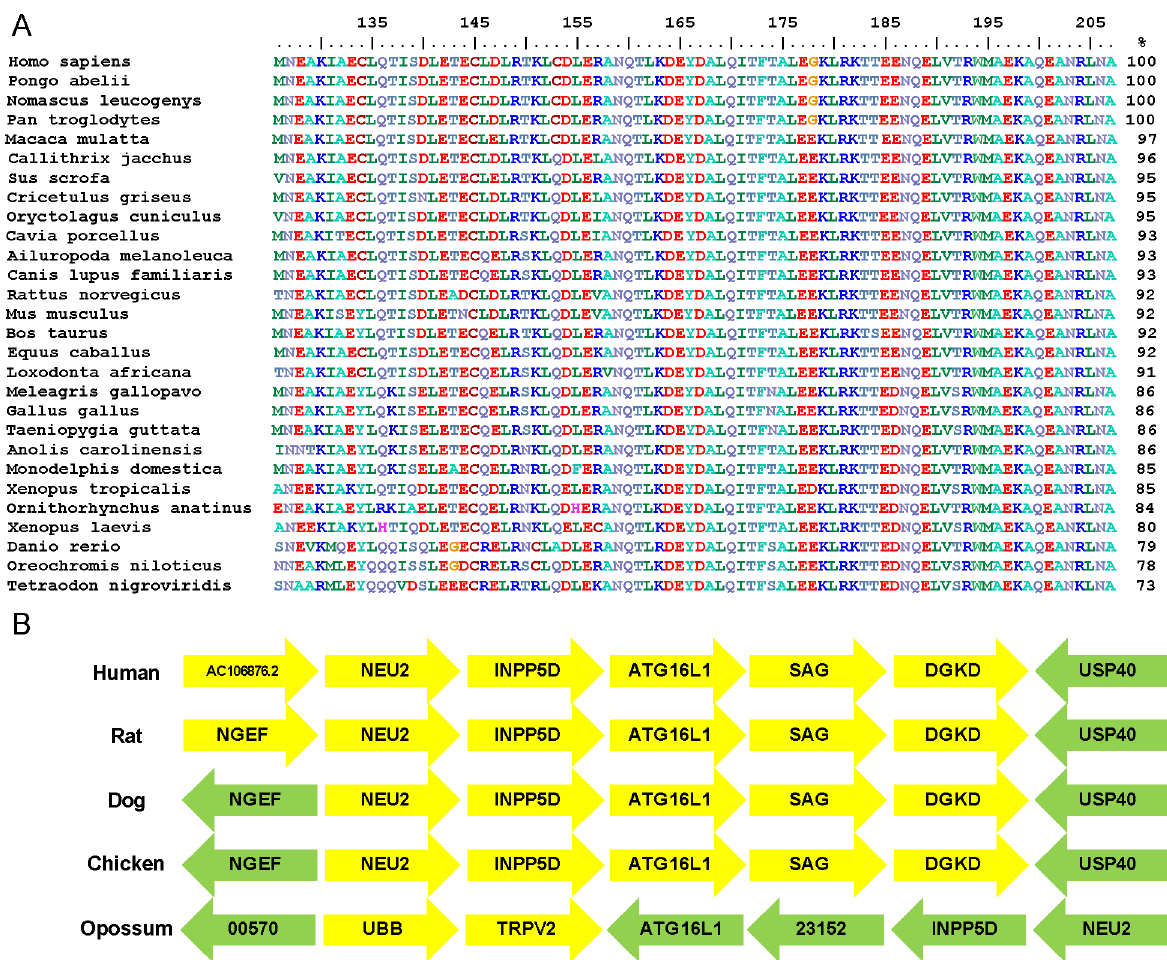
Figure 5. The coiled-coil of ATG16L1 is highly conserved across vertebrates. (A) Cross-species alignment of the coiled-coil (human residues M126 – A207) of ATG16L1 reveals levels of sequence identity with the human sequence of between 73% and 100%. The percentage identity listed is in comparison with the human sequence. The common names and database identifies for each sequence are listed in Materials and Methods. (B) The syntenic position of Atg16L1 is well conserved across species. The three adjacent upstream and downstream genese to Atg16L1 are displayed. Genes are denoted by individual blocks; yellow indicates a position on the forward strand and green a position on the reverse strand. Gene identities are as follows: ATG16L1 – autophagy related protein 16 isoform 1; SAG – S-antigen, retina and pineal gland; DGKD – diacylglycerol kinase delta; USP40 – ubiquitin specific peptidase 40; INPP5D – inositol polyphosphate-5-phosphatase; NEU2 – sialidase 2; NGEF - neuronal guanine exchange factor; TRPV2 – transient receptor potential cation channel, subfamily V, member 2; UBB – ubiquitin B; AC106876.2 – uncharacterised;